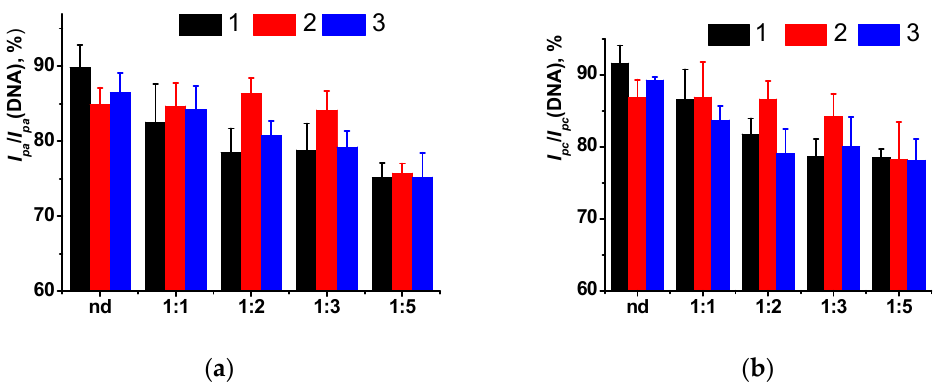
Figure 7. The influence of the human urine dilution on relative shift of the oxidation ( a ) and reduction ( b ) peak currents, measurements on the (PAA+CB)/DNA+MB-based DNA-sensor, samples from three individuals, sample dilution 1:1, 1:2, 1:3, 1:5, nd—not diluted; 0.1 M phosphate buffer with 0.1 M NaNO 3 , pH 7.0, scan rate 100 mV/s.